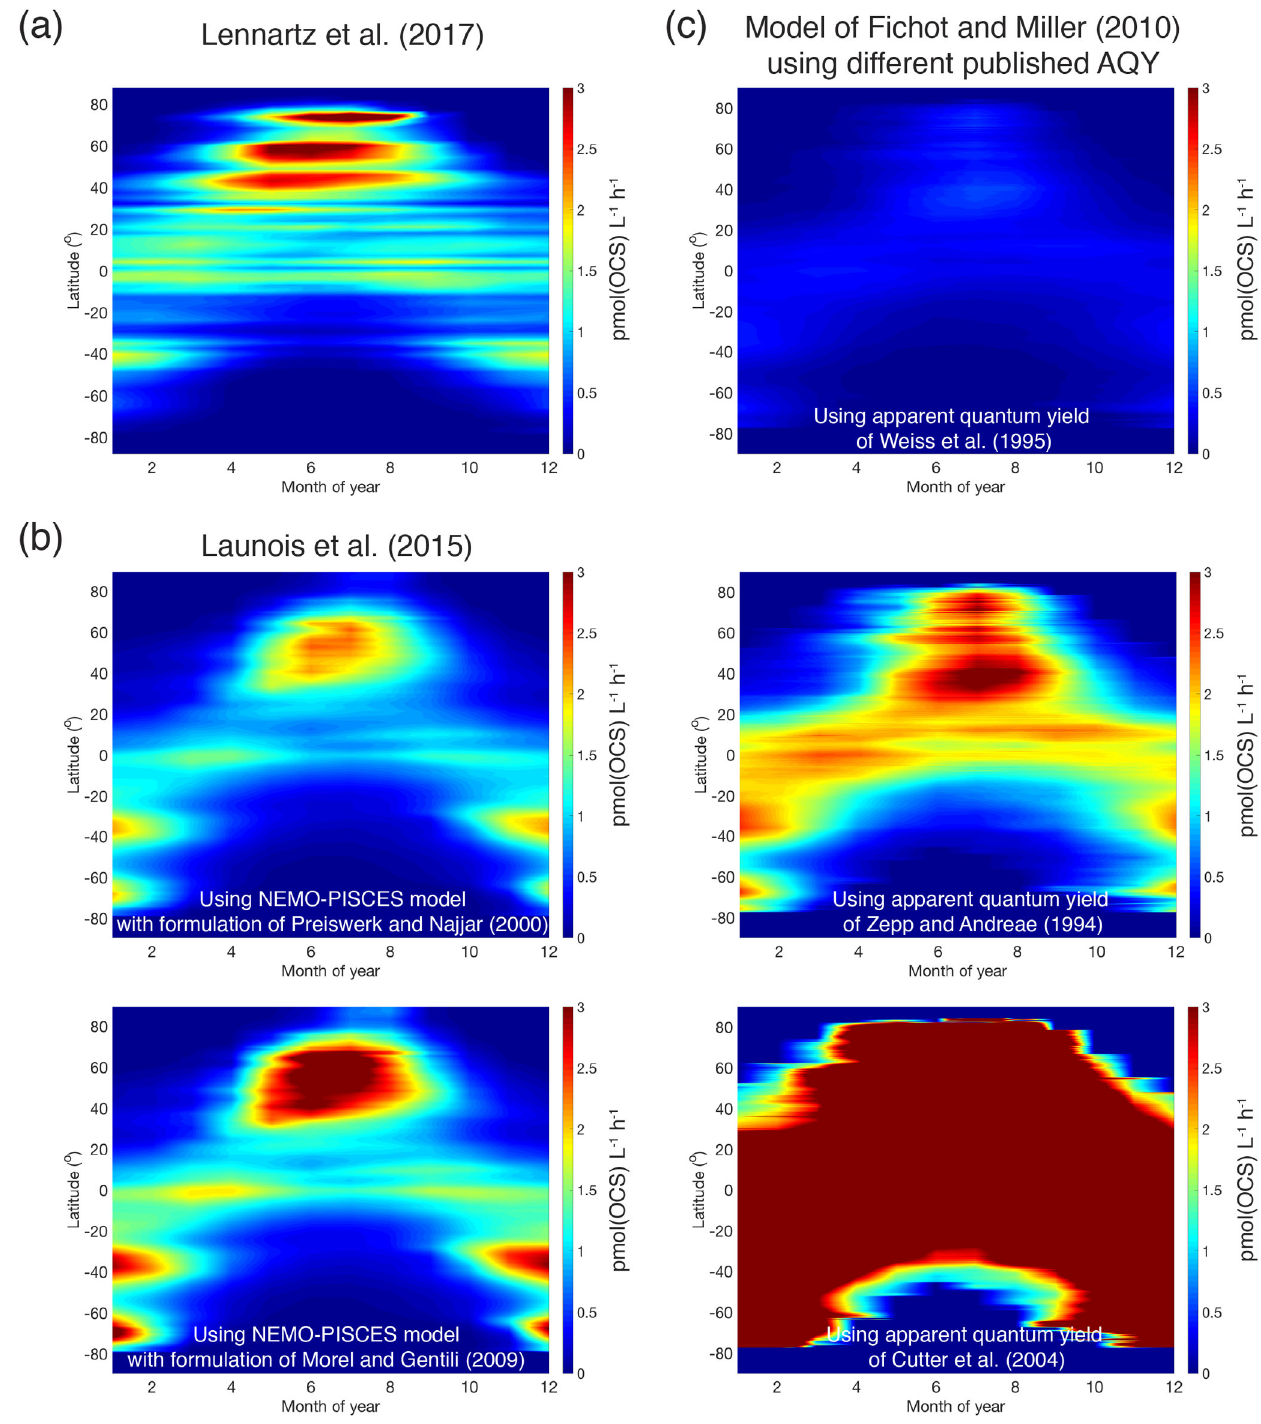
Figure 9. Comparison of OCS photoproduction rates (averages for surface mixed layer, pmol(OCS) L − 1 h − 1 ) modeled using different approaches and demonstrating discrepancies between methods: (a) Hovmöller (latitude–time) plot of rates calculated using the approach described in Lennartz et al. (2017); (b) the same Hovmöller plot generated with the approach described in Launois et al. (2015a) and two different formulations for CDOM absorption coefficients from Preiswerk and Najjar (2000) and Morel and Gentili (2004); and (c) the same Hovmöller plots generated with the photochemical model of Fichot and Miller (2010) and the published spectral apparent quantum yields of Weiss et al. (1995), Zepp and Andreae (1994), and Cutter et al.